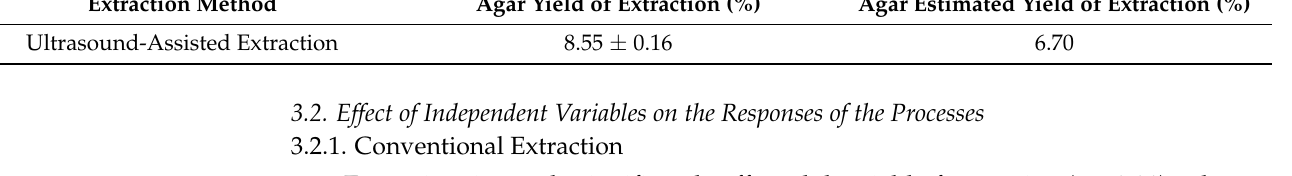
Table 6. Agar yields obtained from optimized Ultrasound-Assisted Extraction and re-extraction ( n = 2). Extraction